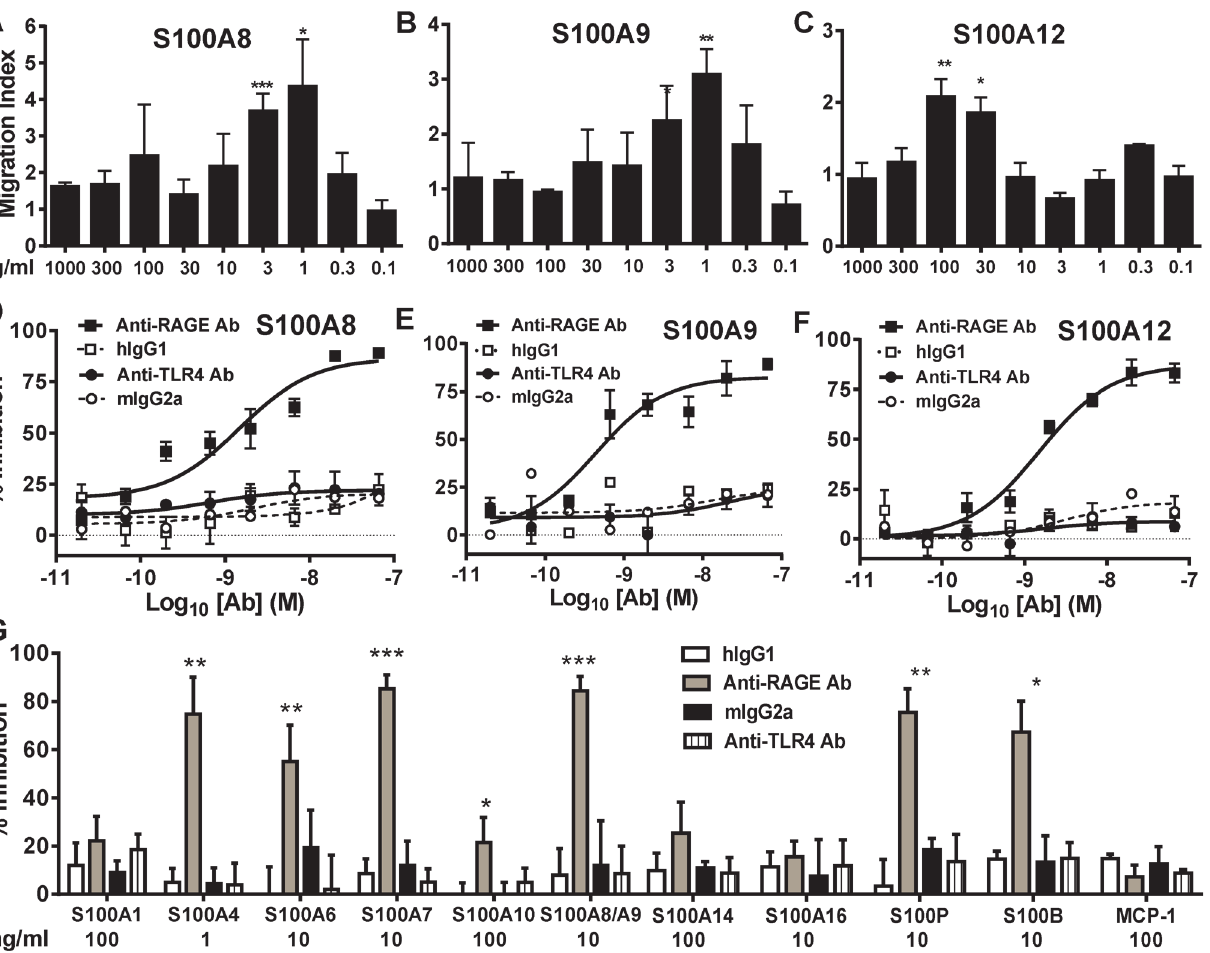
Fig 2. RAGE blockade inhibits calgranulin (hS100A8, hS100A9 or hS100A12) induced THP-1 cell migration but does not impact migration of all S100s. Migration indices for THP-1 cells in response to hS100A8 (A), hS100A9 (B), and hS100A12 (C). Effects of anti-RAGE, anti-hTLR4 Abs and isotype control Abs on hS100A8 (D), hS100A9 (E) and hS100A12 (F) induced THP-1 cell migration. Serial dilution of anti-RAGE, anti-TLR4 or isotype-matched control Ab were incubated with THP-1 cells in the upper wells of the chemotaxis chamber, and optimal amounts of hS100A8 (1 ng/ml), hS100A9 (1 ng/ml) and hS100A12 (100 ng/ml) were added in the lower wells. Percentage inhibition is relative to no Ab treatment. One representative of three independent experiments is shown (mean ± SD of triplicate wells) (G) The effects of a fixed 10 μ g/ml dose of anti-RAGE, anti-hTLR4 and control Abs on THP-1 cell migration mediated by other S100s and MCP1. The S100s were used at their optimal concentrations (indicated on graphs). The maximal chemotactic indexes were S100A1 (2.0), S100A4 (2.9), S100A6 (2.9), S100A7 (3.7), S100A8/A9 (3.1), S100A10 (1.9), S100A14 (2.7), S100A16 (2.4), S100P (3.5), S100B (3.5) and MCP1 (9.5). Percentage inhibition is relative to no Ab treatment. Mean inhibition ± SD for one of two independent experiments is shown. Unpaired T-test was used to determine if the anti-RAGE or anti-hTLR4 Ab treatments were significantly different from the isotype control Ab ( * P < 0.05, ** P < 0.01, *** P <